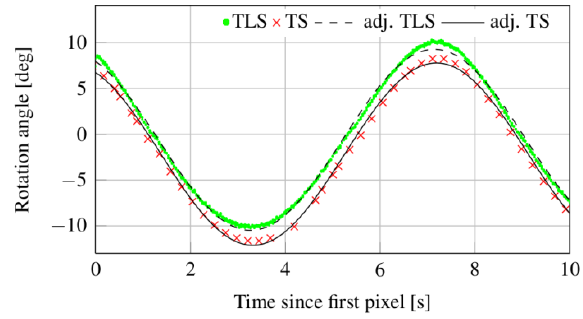
Figure 4: Captured oscillation from TLS of a sectional plane (green points) and trace of the prism as captured by the total station (red crosses). Adjusted results are represented by a dashed line (TLS) and a continuous line (total station)